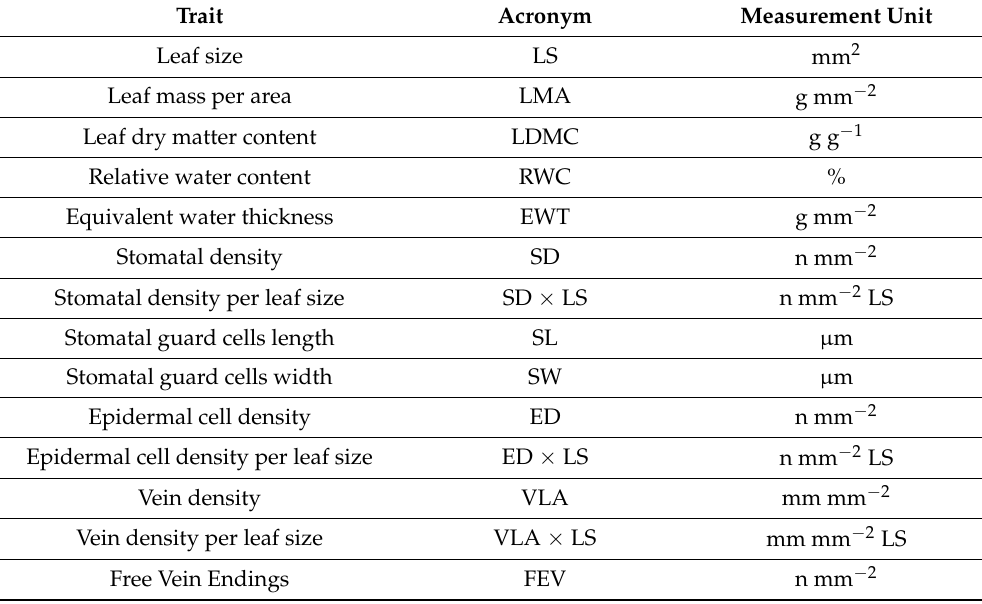
Table 5. A list of measured traits and their measurement unit. Trait Acronym Measurement Unit Leaf size LS mm